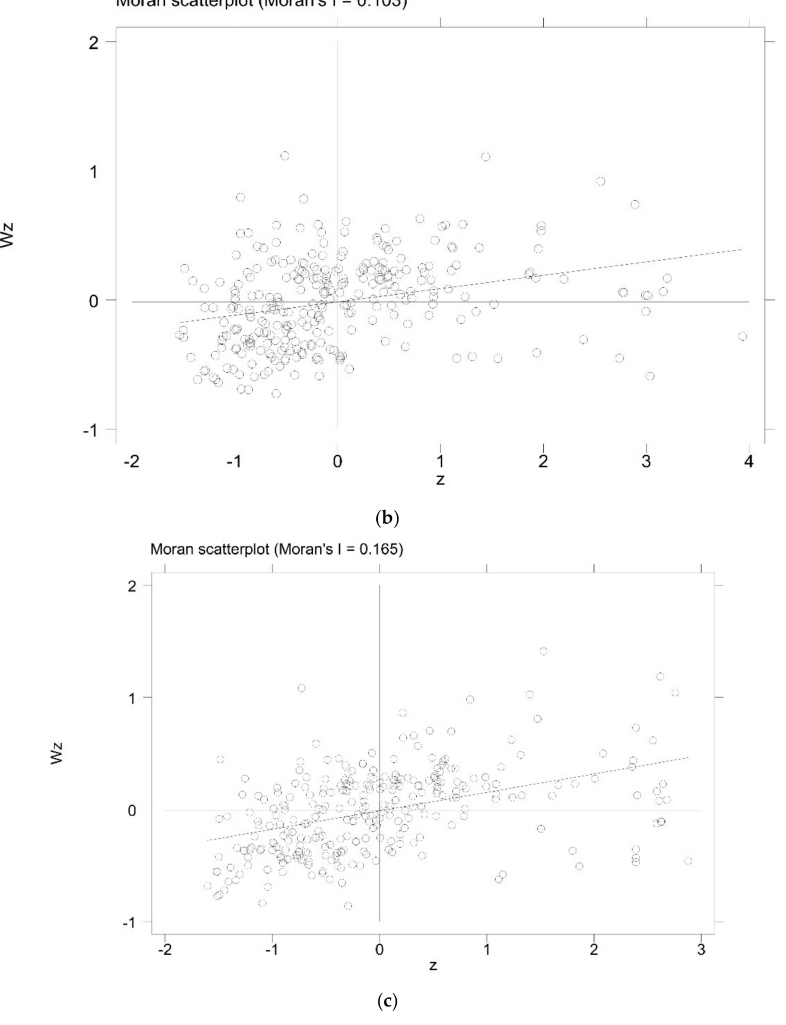
Figure 4. Moran scatter plots of citylevel CE ( a ) 2003, ( b ) 2010, ( c ) 2017.